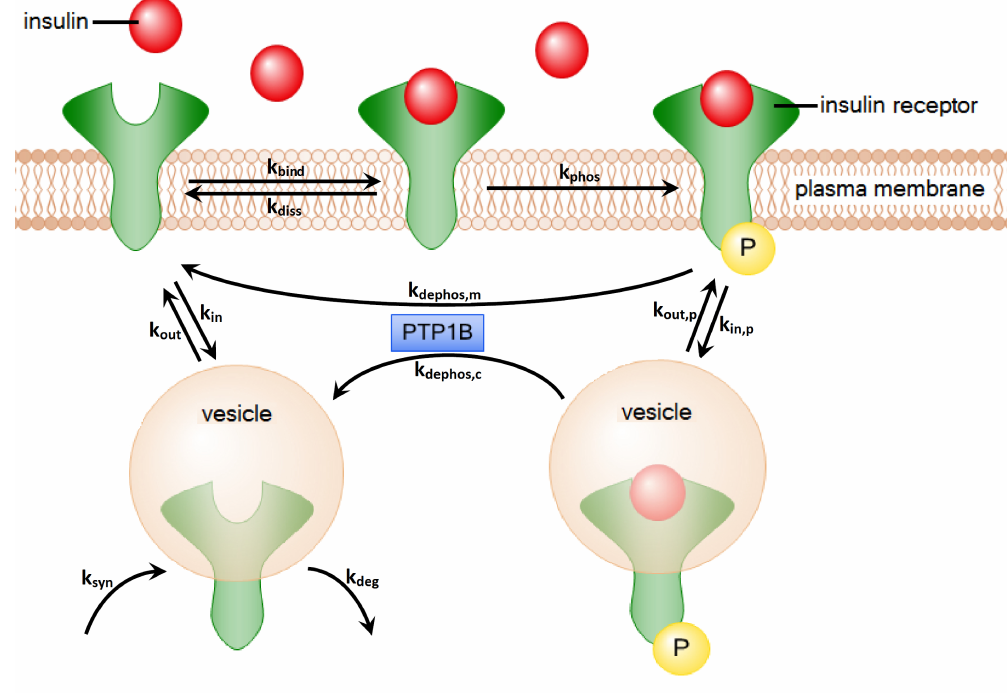
Figure 1. The processes of insulin-dependent activation and recycling of the IR. First, insulin binds to the IR. Afterwards, the IR gets